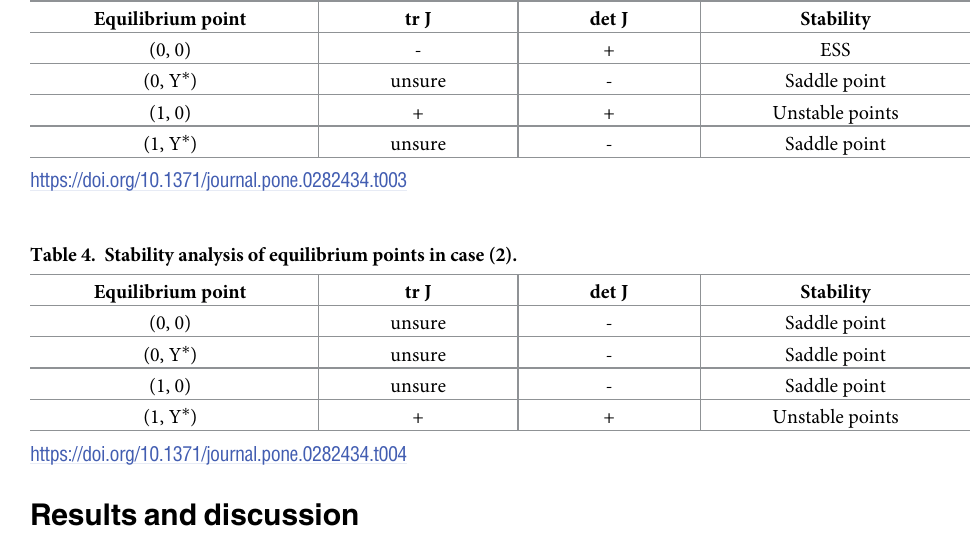
Table 3. Stability analysis of equilibrium points in case (1).